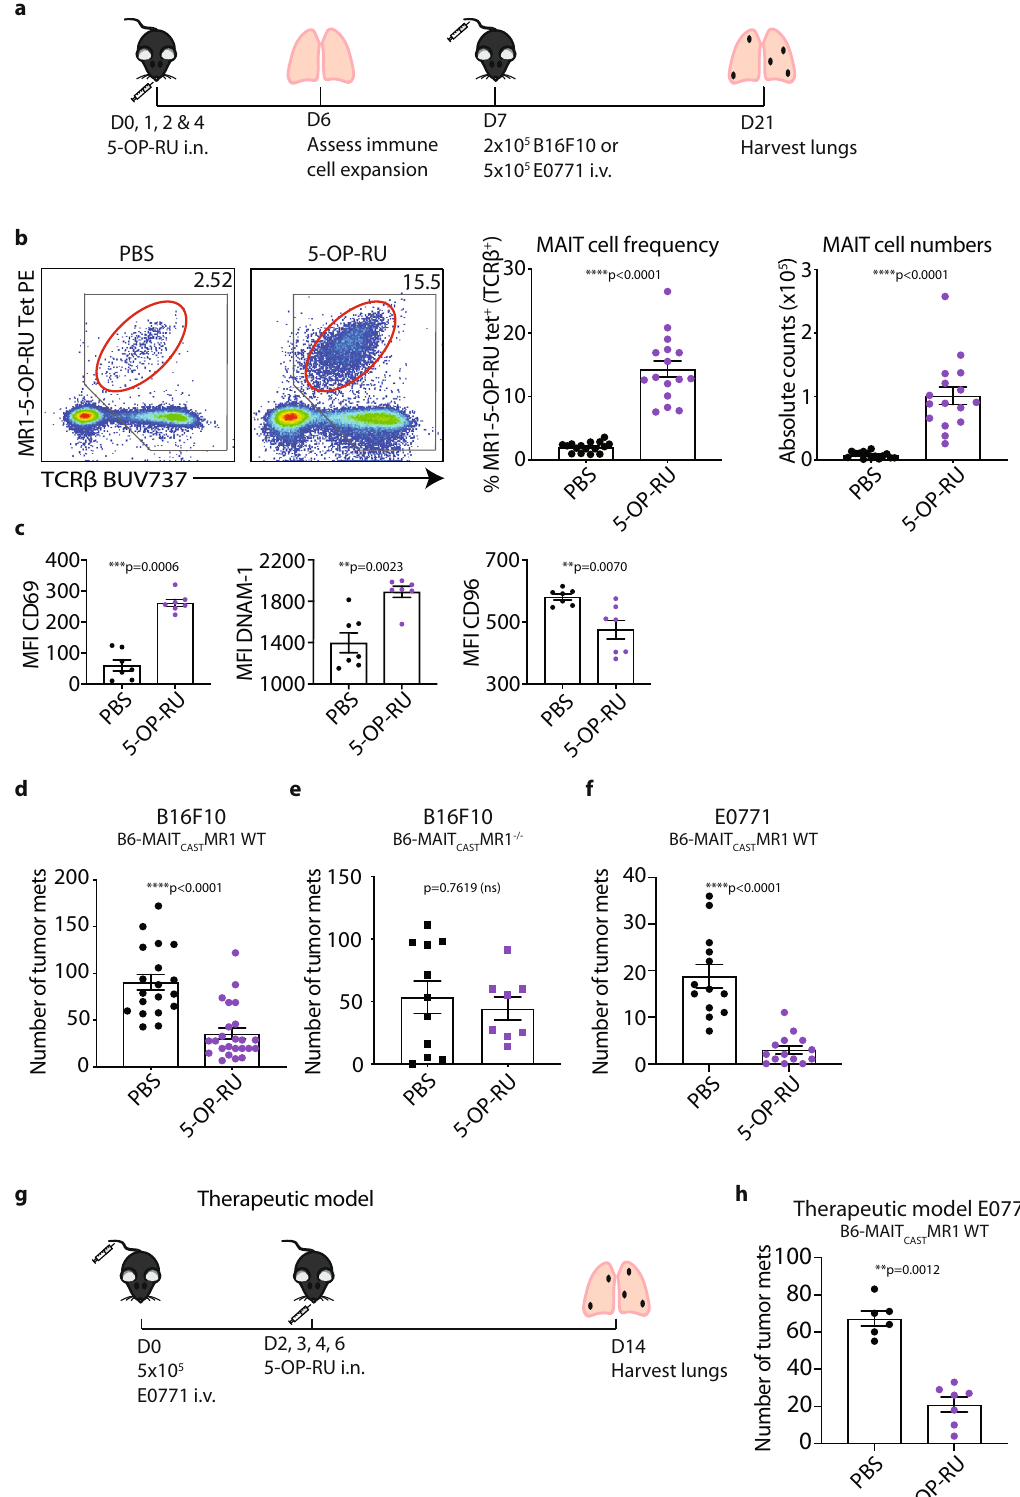
(Supplementary Fig. 4b, c). Given that this data suggested that IFN- γ -mediated activation of NK cells occurred following 5-OP-RU treatment, we next assessed the source of IFN- γ during this MAIT cell expansion protocol. Consistent with our RNA-seq analysis (Supplementary Fig. 6a), we observed increased IFN- γ and TNF